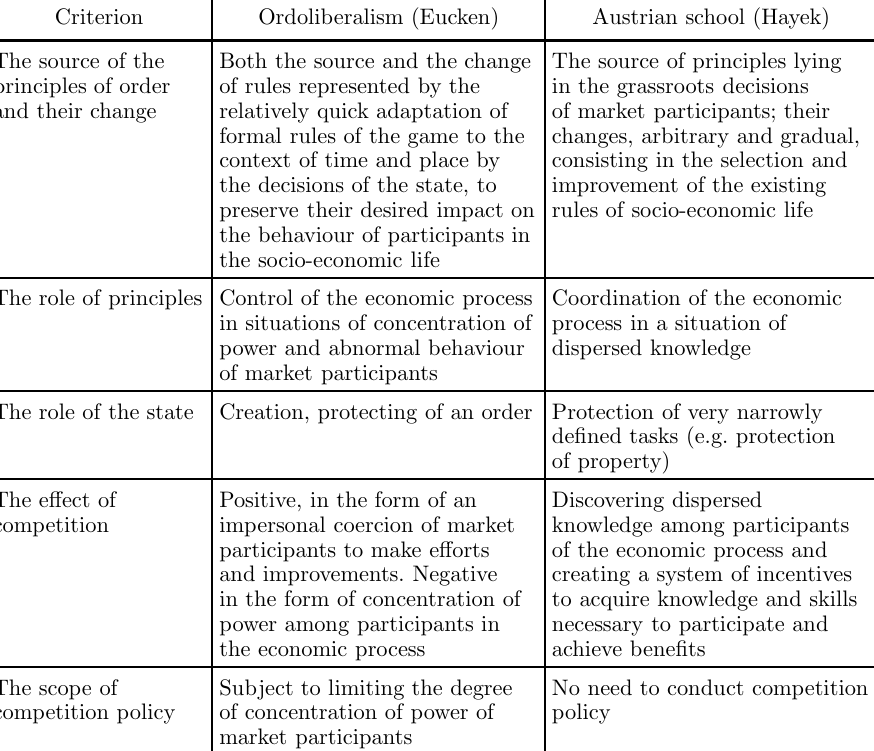
Comparison of the theory of economic order by Eucken and Hayek Criterion Ordoliberalism (Eucken) The source of the Both the source and the change principles of order of rules represented by the and their change relatively quick adaptation of formal rules of the game to the context of time and place by the decisions of the state, to the socio-economic life